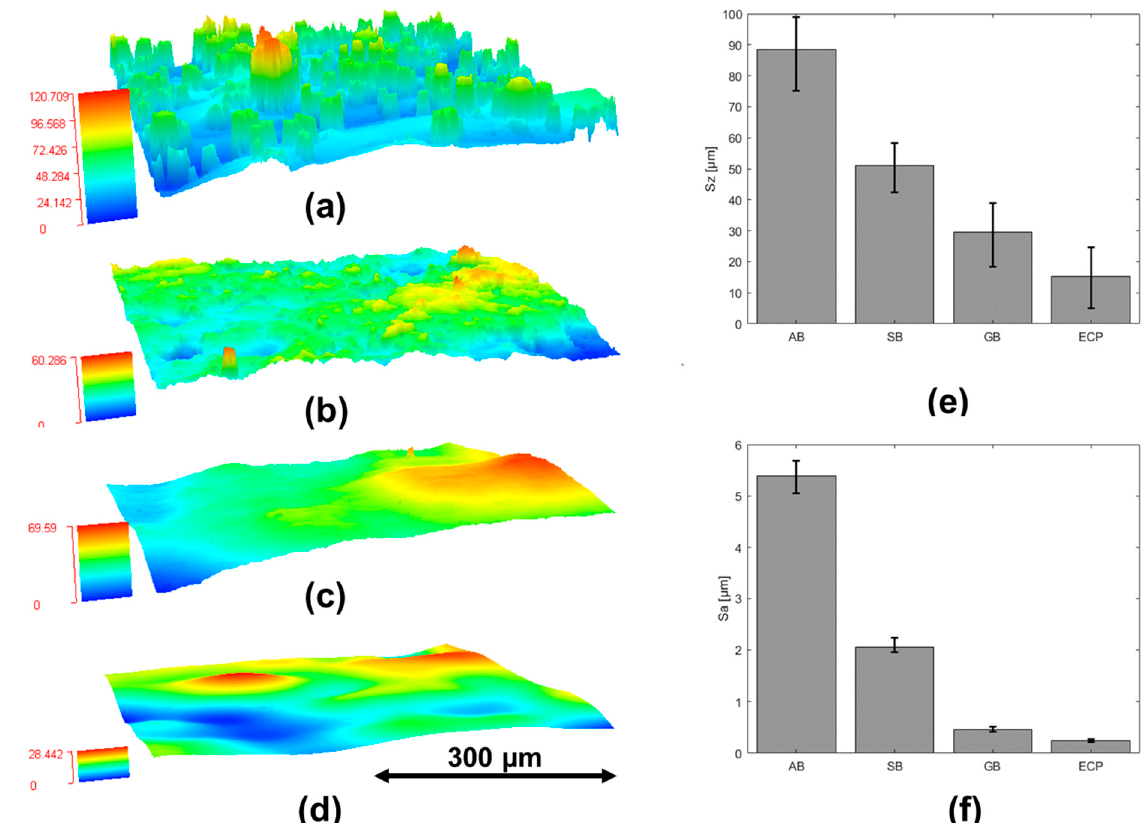
Figure 16. Surface roughness profiles of the L-PBF-manufactured specimen geometries in different conditions with the intensity profile in µm: ( a ) as-built, ( b ) sand-blasted, ( c ) glass-bead-blasted, ( d ) electrochemically polished. Measured roughness values plotted and compared in terms of ( e ) Sz value and ( f ) Sa value.